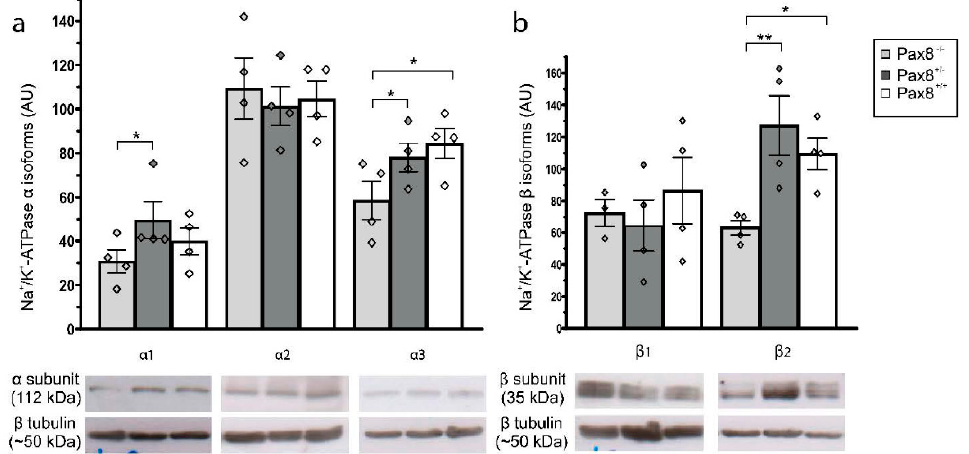
Figure 3. Effects of congenital hypothyroidism on sodium potassium ATPase α and β subunit expression. Protein levels of Na + /K + -ATPases ( a ) α 1, α 2, and α 3 isoforms, and ( b ) β 1 and β 2 isoforms from P19–P21 old Pax8 − / − (light gray), Pax8 +/ − (dark gray), and Pax8 +/+ (white) mice. Exemplary immunoblotting bands are shown below bar charts. β tubulin was used as internal control. Bars represent means ± SEM. Data from individual animals depicted as diamonds. Statistically significant differences marked with * ( p < 0.05) or ** ( p < 0.01), n = 3–4 for each condition.